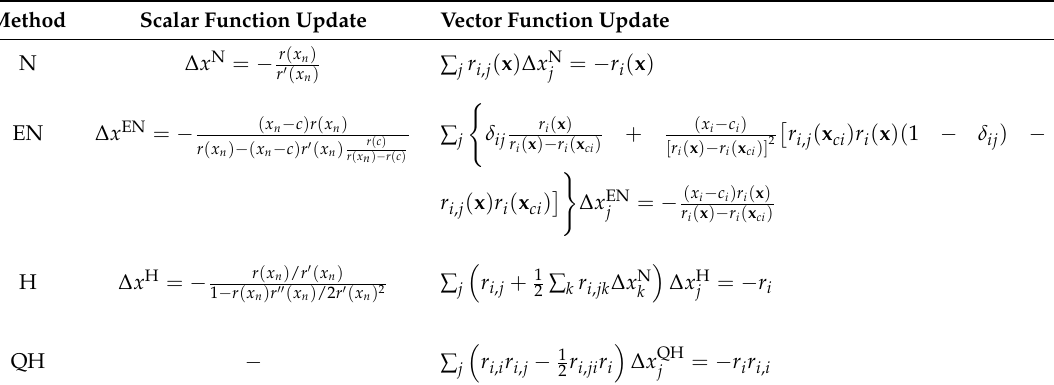
Table 1. Summary of Newton’s method and its proposed